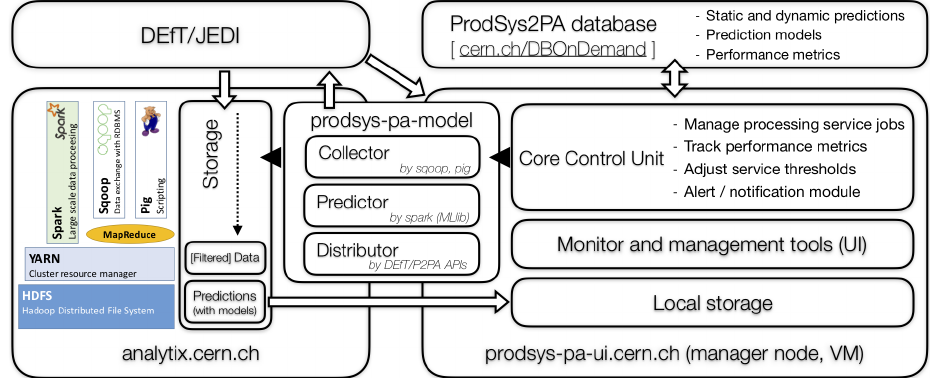
Figure 2. The architecture of the prototype of the ProdSys2 Predictive Analytics service (the Hadoop cluster “analytix” with highlighted service components as provided by